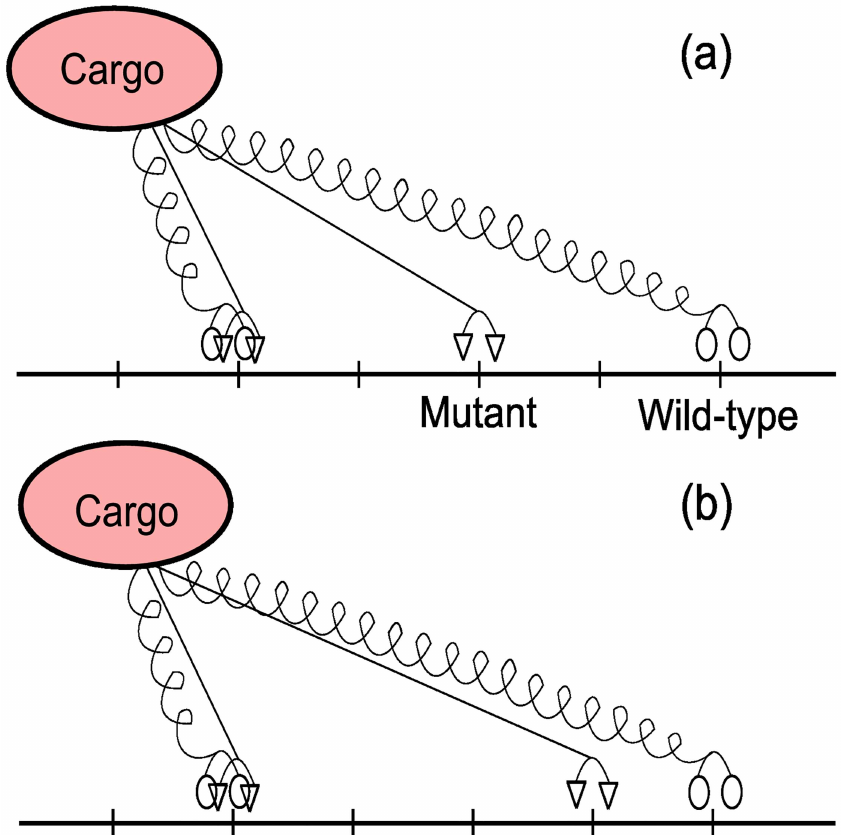
Fig 17. Locations of wild-type and mutant motors on a section of the microtubule lattice. The string representation for the two configurations is ( a ) | M h M d || M d || M h | and ( b ) | M h M d ||| M d | M h